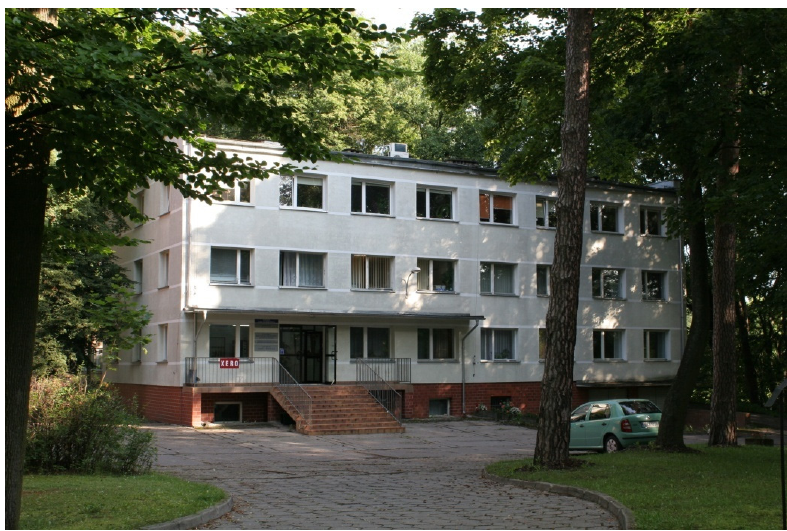
Energies 2022 , 15 , x FOR PEER REVIEW Figure 1. The selected educational building in the campus of the UWM in Olsztyn.